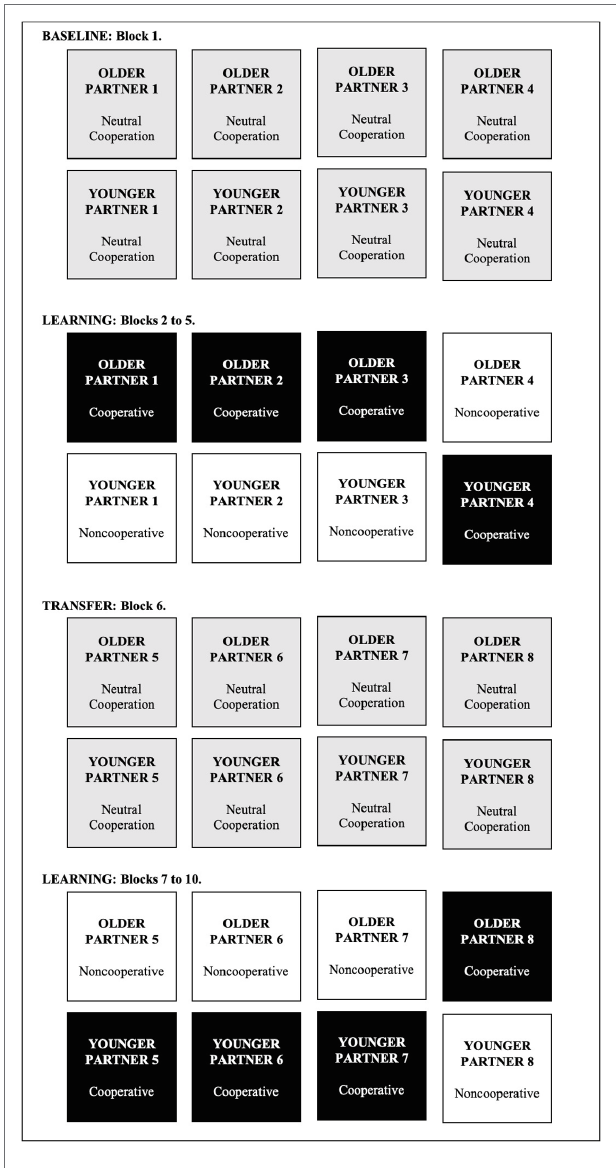
FIGURE 1 | Example of the procedure employed for the trust game. Consistent partners are represented in white and inconsistent partners are represented in black. In the baseline and transfer phases, partners are presented for the first time and their cooperative behavior is not